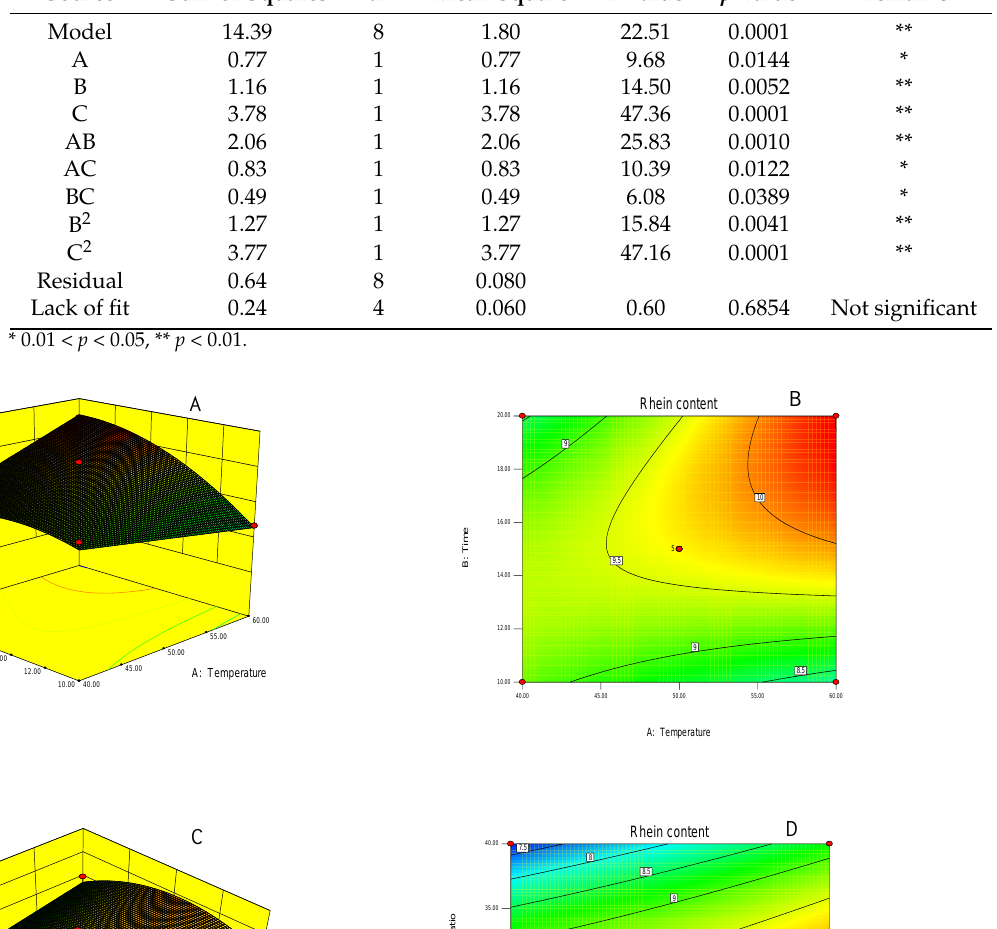
Table 6. ANOVA of the quadratic model for rhein contents of S. alata leaf extracts. Source Sum of Squares